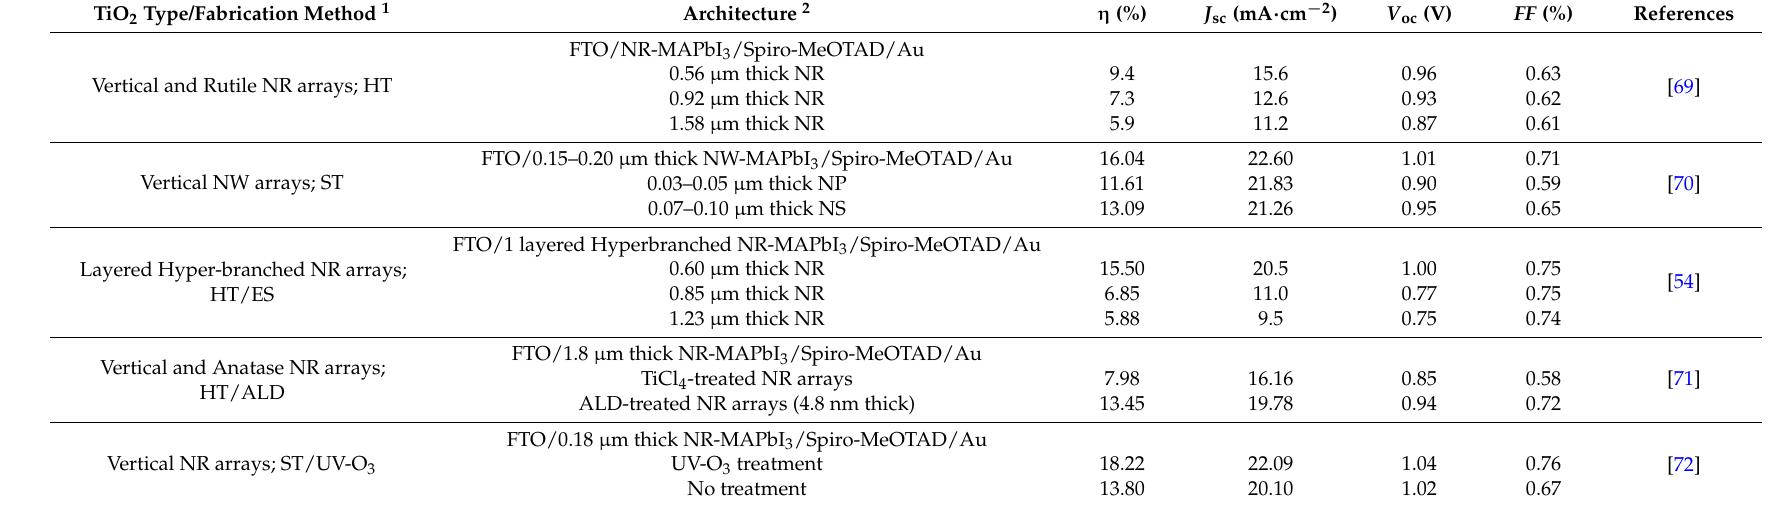
Table 2. Summary of photovoltaic characteristics for PSCs using 1D TiO 2 nanostructured